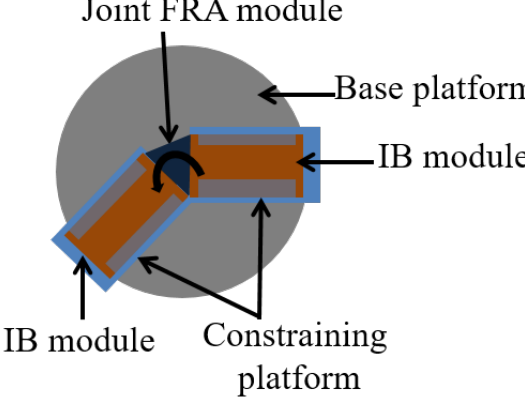
Figure 4. Illustration of passive resistive torque measurement set up of the SNG assembly.